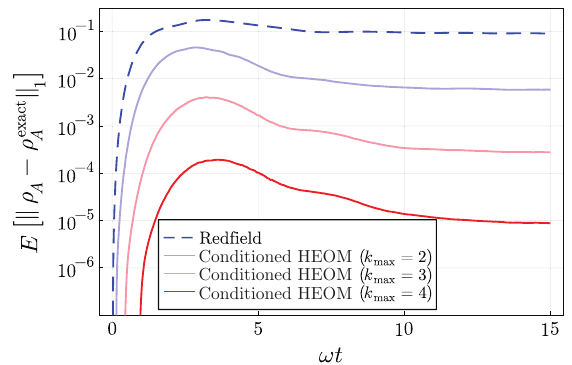
|| FIG. 3. Average trace distance E [ || ρ A − ρ exact 1 ] of homo- A ( t ) dyning trajectories ρ A ( t ) [Eq. (13)] to the exact result ρ exact A for the driven Jaynes-Cummings model with g = 2 ω , ε = 0.5 ω , (cid:2) = ω , and κ = 2 ω using different approximation schemes, √ where || O || 1 = tr O † O denotes the trace norm of an operator O . The average is taken with respect to 1000 samples of the homodyne current and the initial state is | 1 (cid:2)